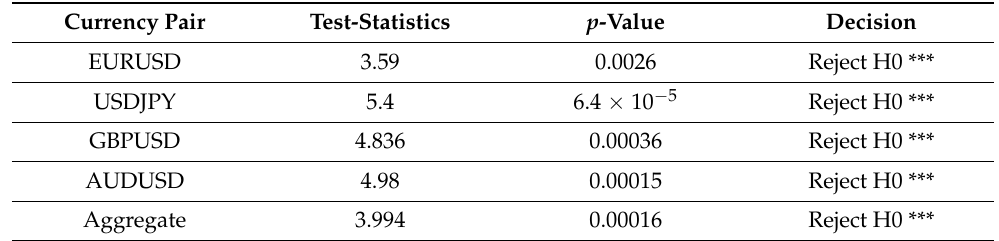
Figure 3. This figure shows the distribution of actual outcome class for class-1 predictions for mod- els trained with and without the SR features for the 4 most traded currency pairs. Table 4. The t -Test results which corresponds to the class-1 precision performance distribution in Figure 2a. A total of 20 models were trained on each dataset (currency pair) where a set of 10 models was trained with the SR levels identified and a set of 10 models was not. t -Test is used to measure the statistical significance of the performance distribution differences between the 2 sets. *** refer to the 99% confidence coefficient, respectively. Results show that the performance distribution differences are significant for all